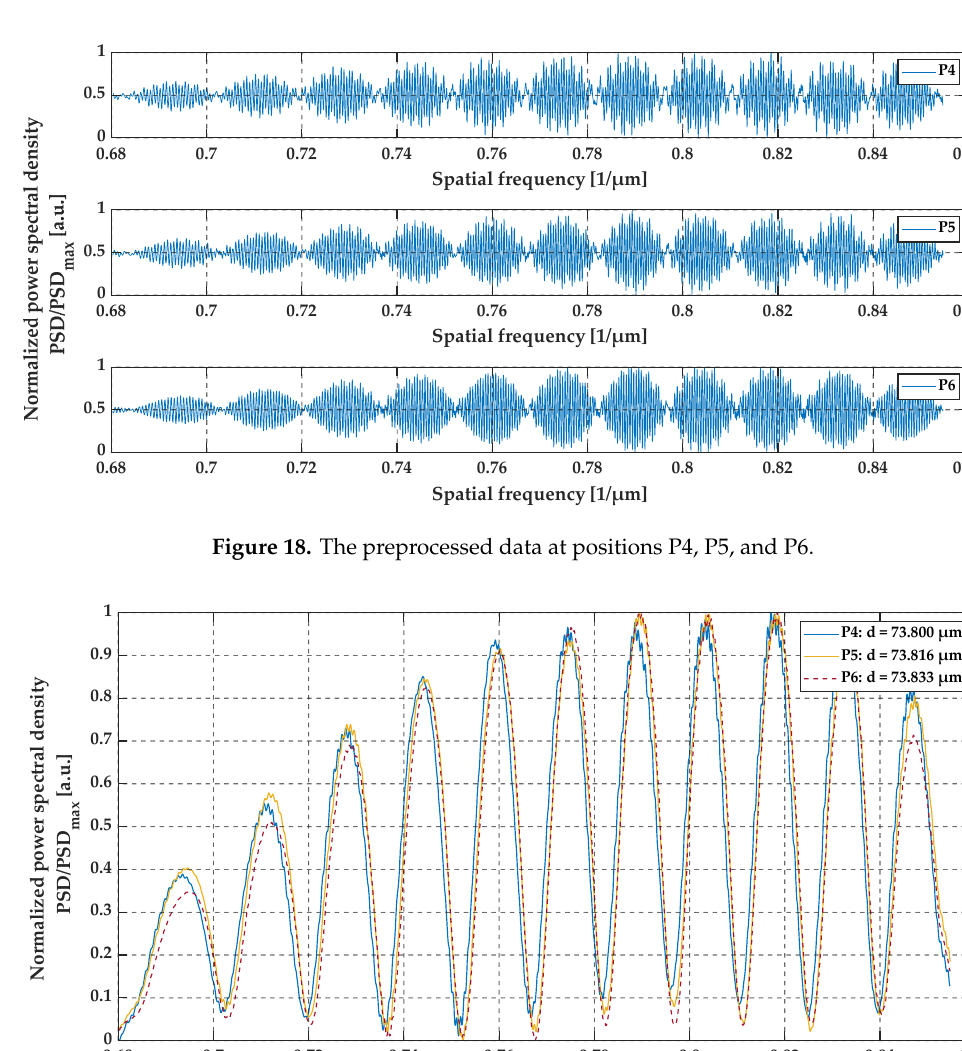
Figure 17. The A-scans at positions P4, P5, and P6.